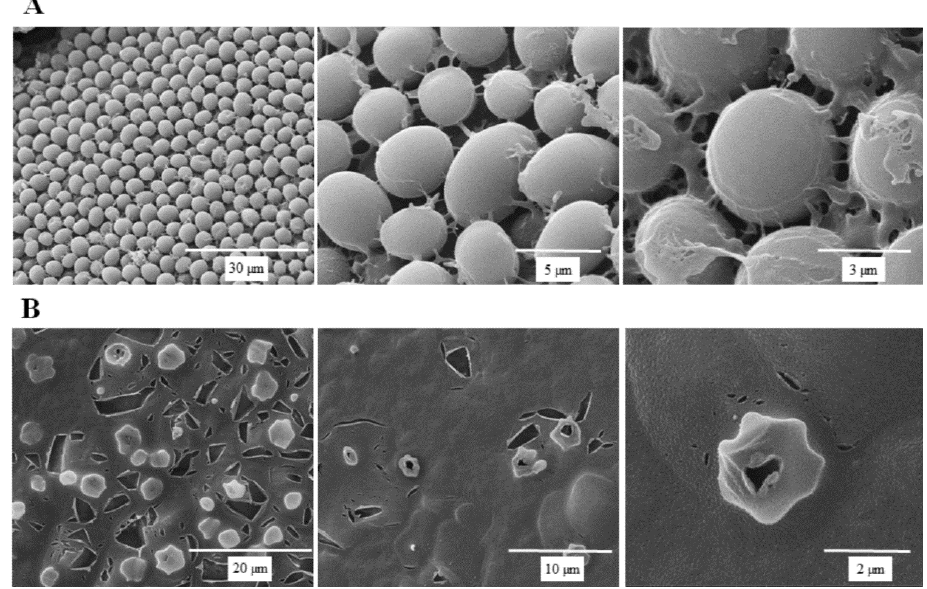
Figure 5. Scanning electron micrographs of C. albicans . ( A ) A scanning electron micrograph of C. albicans cells after 40 h cultivation at 37 °C. ( B ) A scanning electron micrograph of C. albicans cells after 40 h of SSE exposure on an agar plate with 0.25 mg/mL at 37 °C.